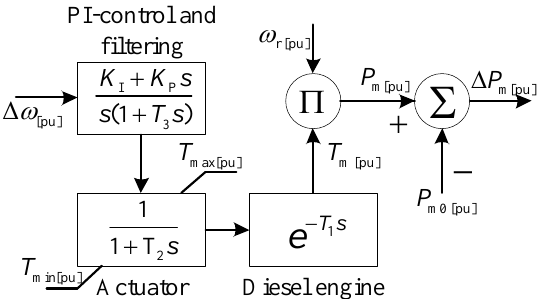
Figure 4. Speed governor model of the thermal generation used in the study.